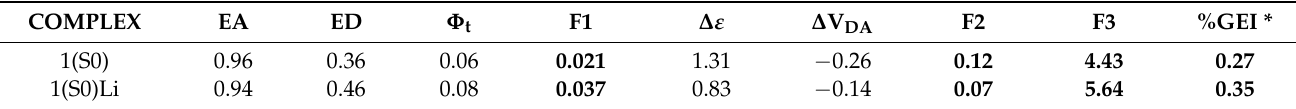
Table 8. Calculated values for the Global Efficiency